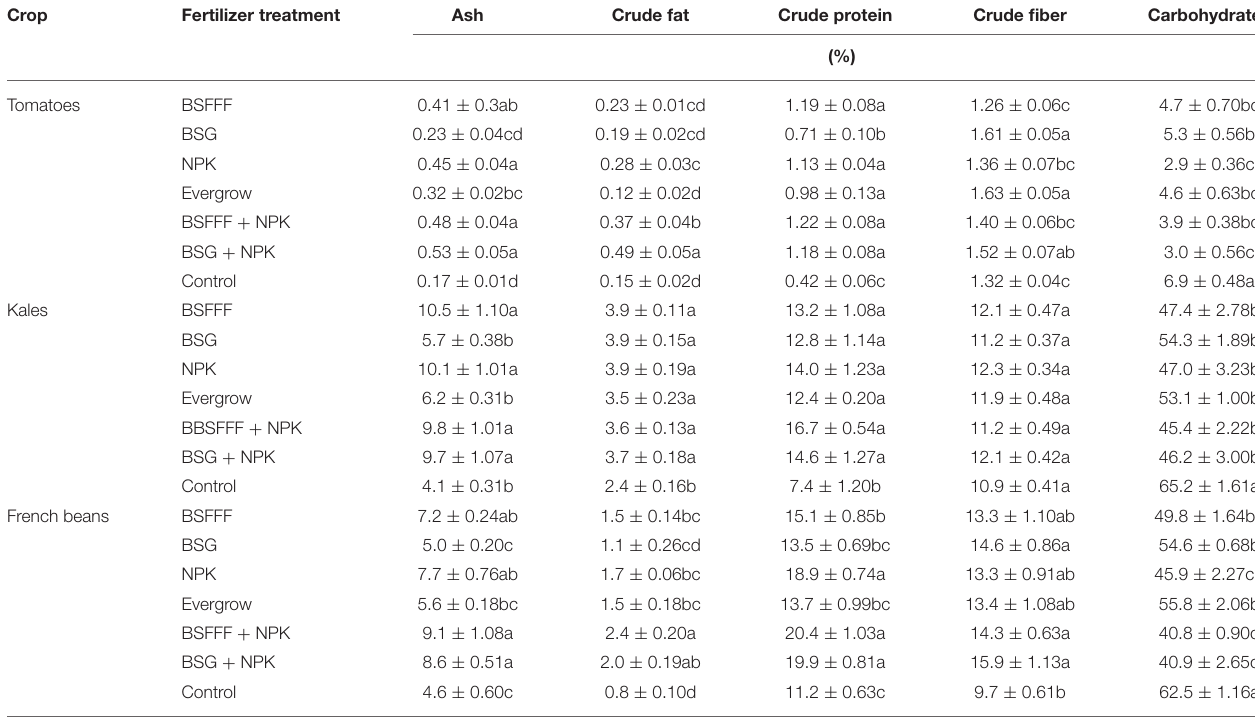
TABLE 7 | Influence of composted BSF frass, conventionally composted BSG, and commercial fertilizers on the nutritional quality of tomatoes, kales, and French beans. Crop Fertilizer treatment Ash Crude fat Crude protein Crude fiber